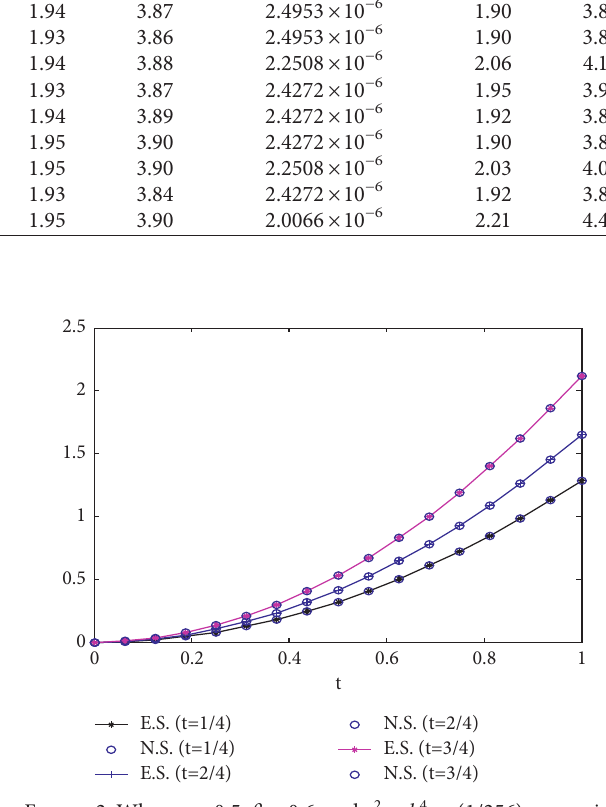
Figure 2: When α � 0 . 5, β � 0 . 6, and τ 2 � h 4 � ( 1/256 ) , numerical methods (24)–(26) are utilized to compare the numerical solutions (N.S.) of problems (73)–(75) with the exact solutions (E.S.) of problems (73)–(75) in t � ( 1/4 ) , ( 2/4 ) , ( 3/4 ) ,